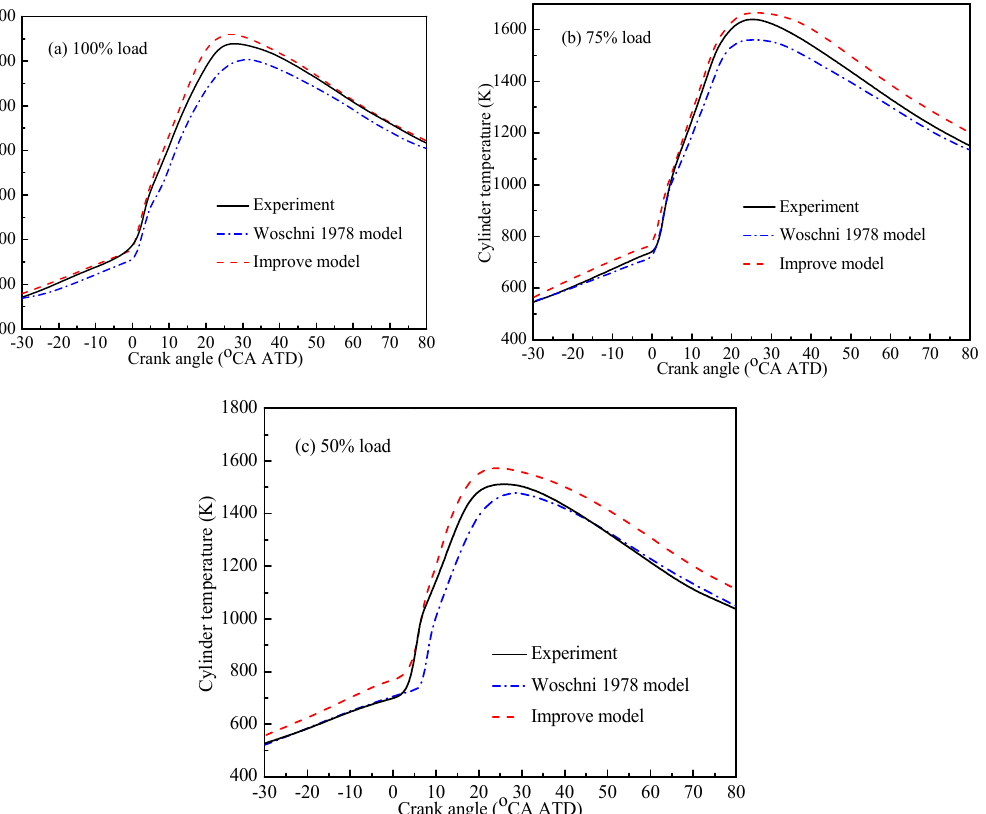
Figure 7. Comparison of cylinder temperature under different load conditions.